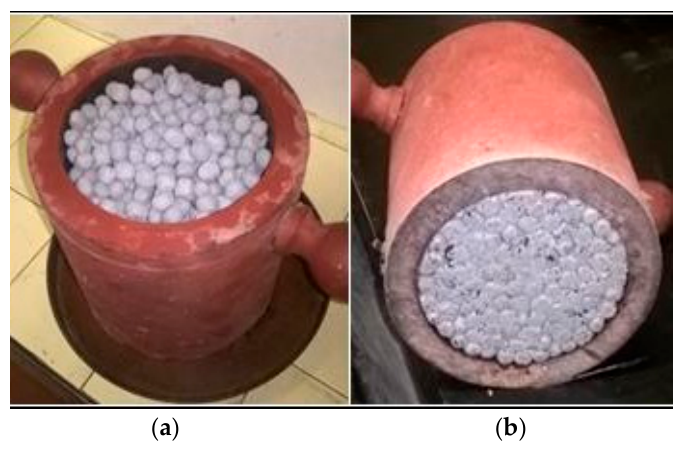
Figure 4. Bulk crushing resistance test of ( a ) before and ( b ) after testing.